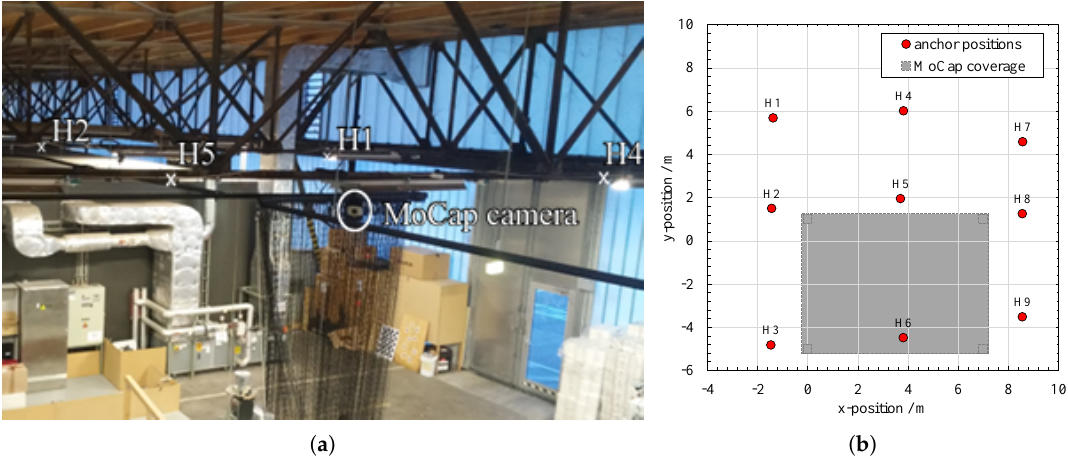
Figure 16. The positions of the anchors H1-9 in the Hangar experiments with an exemplary trajectory of experiment 09. There are 12 anchors in hangar of which we use only 9. The shaded area indicates the coverage of the MoCap system. ( a ) Photo of the Hangar ceiling installation. ( b ) Anchor positions and MoCap